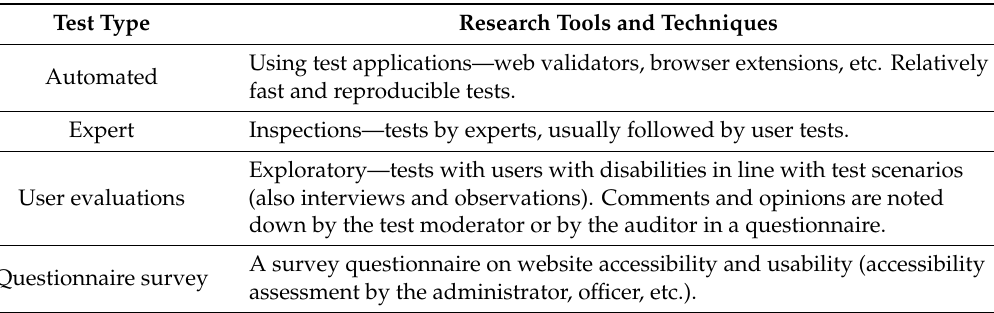
Table 10. Selected types of website accessibility